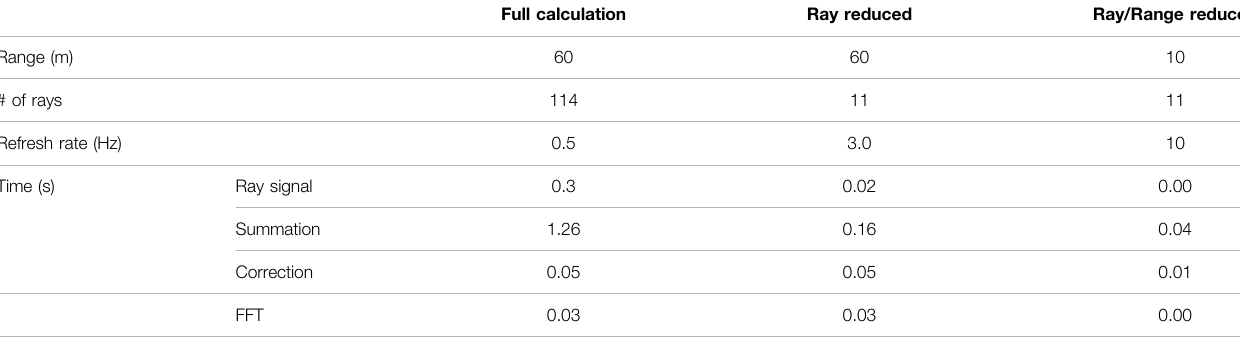
TABLE 2 | The refresh rate and calculation time of the sonar image for various sonar con fi gurations. Full calculation Ray reduced Ray/Range